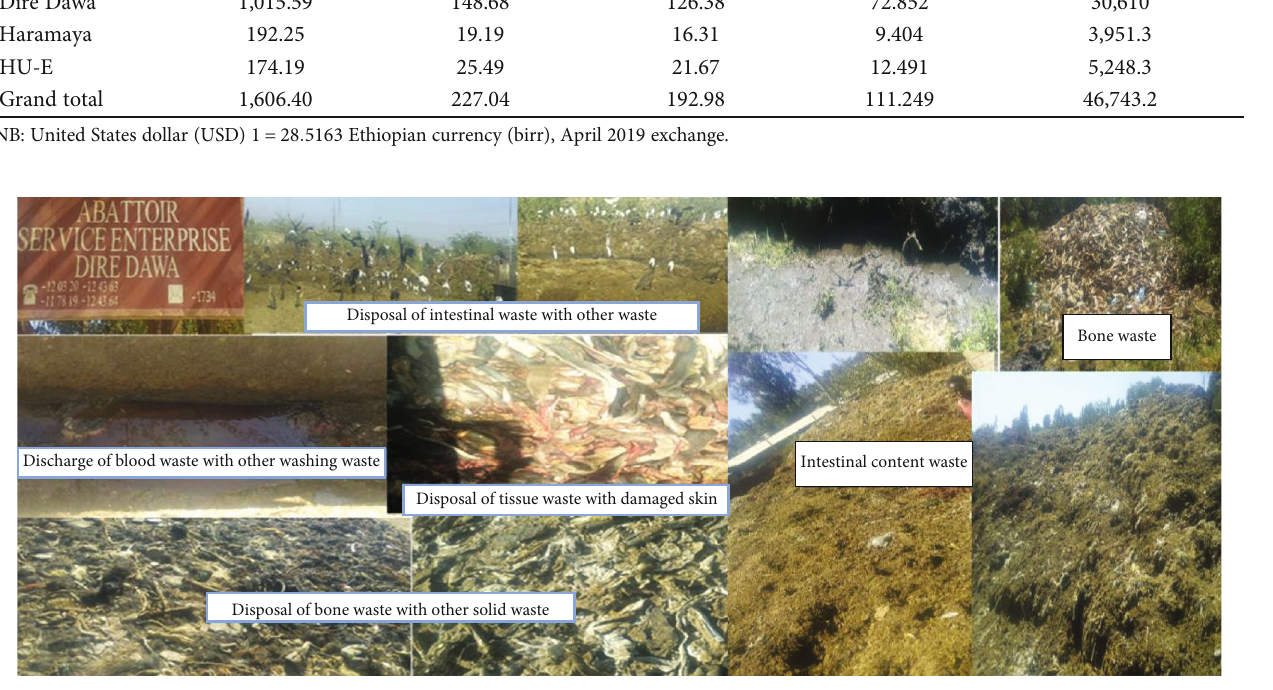
Figure 2: Waste disposal site of abattoir waste from the selected municipality abattoirs, March